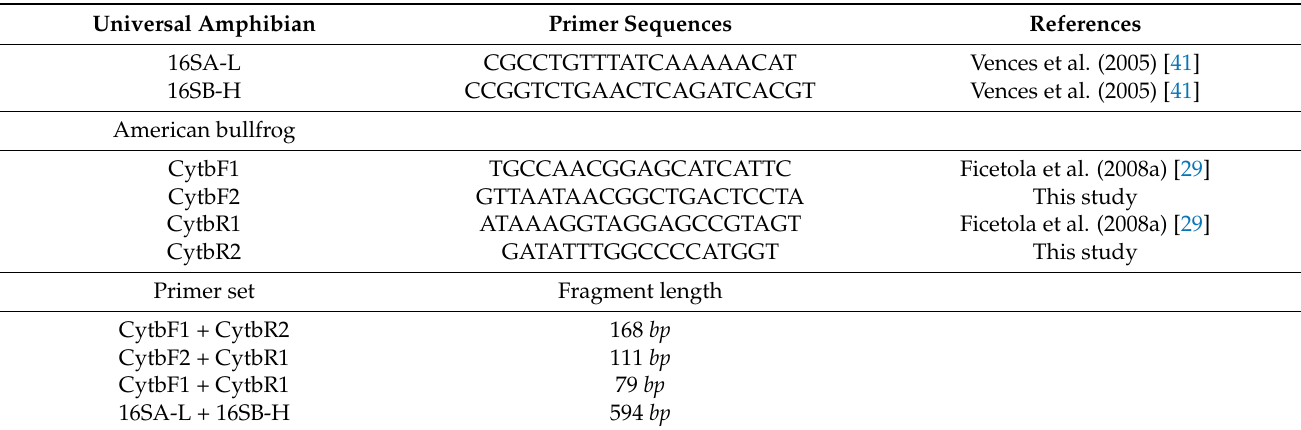
Table 2. Primers used in this study for universal amphibian and American bullfrog DNA